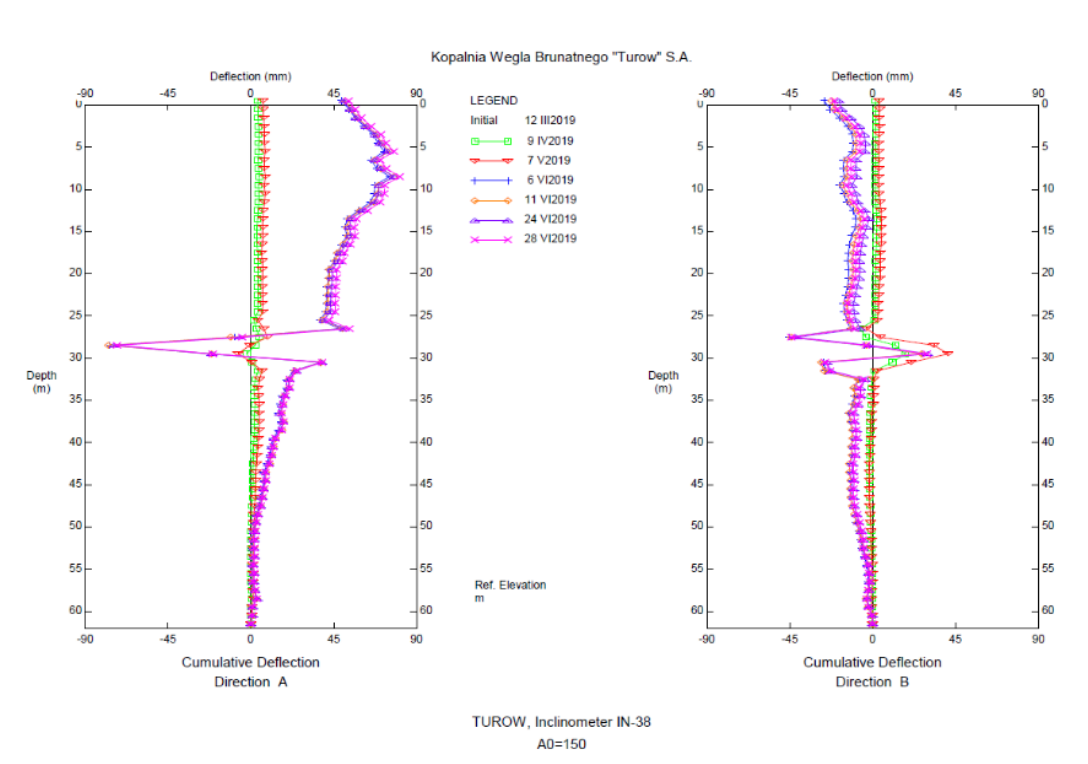
Figure 6: Subsurface displacements on inclinometer